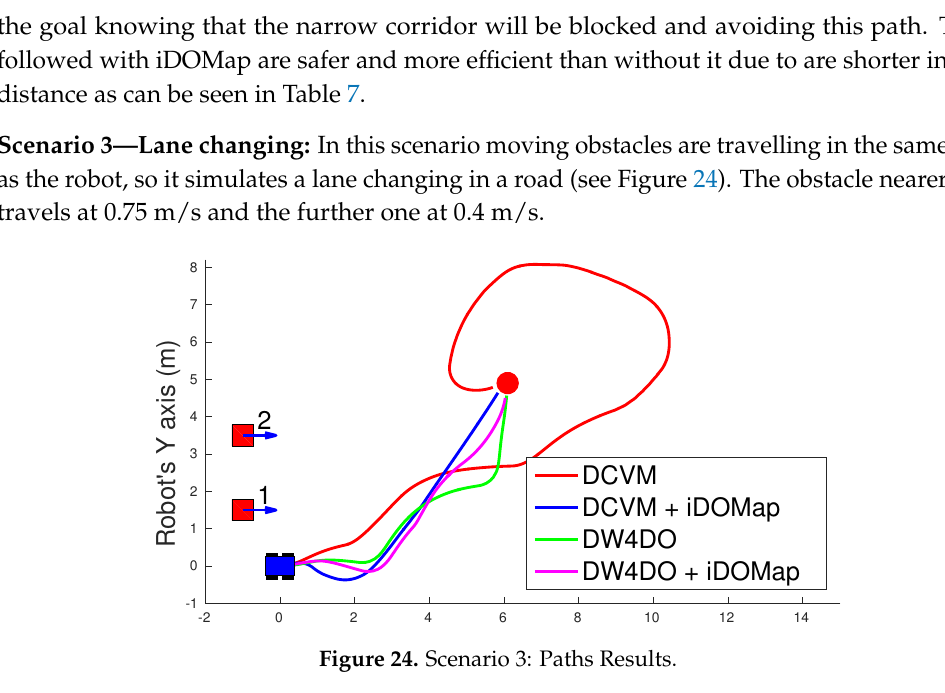
Table 7. Simulated experiments: Results.